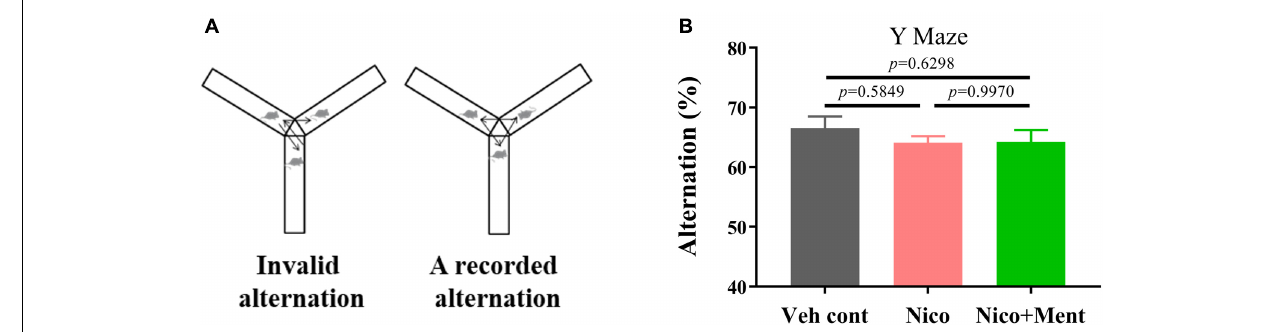
FIGURE 6 | Spatial memory assessment in mice exposed to long-term vapor exposure. (A) Schematic diagram of recorded alternation of one trial in Y-maze. Spontaneous alternation was defined as successive entries into the three different arms (without returning to any arm). (B) The percentage alternation was calculated as the ratio of actual to possible alternations (the total number of arm entries - 2) × 100. The value of * p < 0.05 as determined by ordinary one-way ANOVA and multiple comparisons with every other group. Bars represent marginal means ± SEM. N = 8 per group. Veh cont, Vehicle control; Nico, Nicotine; Nico + ment, nicotine with menthol flavor.